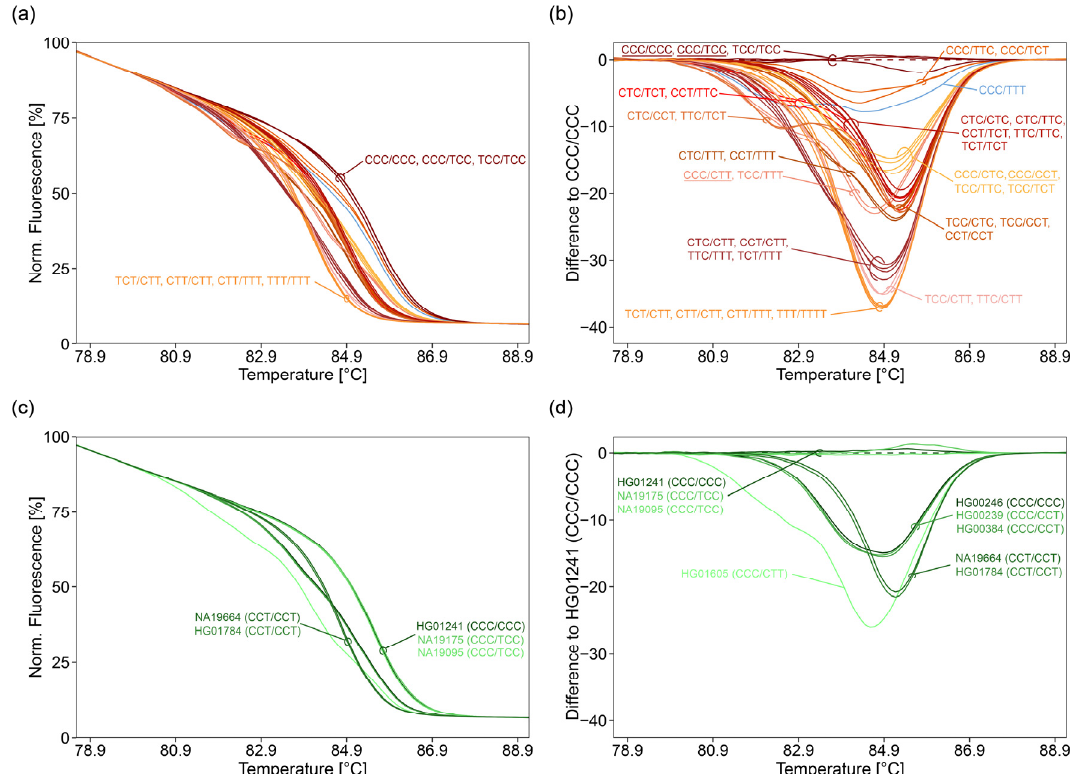
Figure 3. Genotype discrimination of the 2 SNPs assay by HRM analysis. Data are shown as ( a , c ) normalized melt- ing curves and ( b , d ) difference to the triple-homozygous control CCC/CCC of the respective sample set (dashed line). ( a , b ) Only one oligodeoxynucleotide control (blue, CCC/TTT) had a distinguishable melting curve. Manual evaluation of the data obtained for the remaining 35 oligodeoxynucleotide controls resulted in 12 groups of melting curves (orange/red). ( c , d ) Application to NHGRI samples. The melting curve of HG00246, indicated as CCC/CCC in the data base, grouped together with those of HG00384 (CCC/CCT) and HG00239 (CCC/CCT). Data displayed in one plot originated from the same PCR-HRM run. For clarity reasons, the melting curve of one PCR replicate is